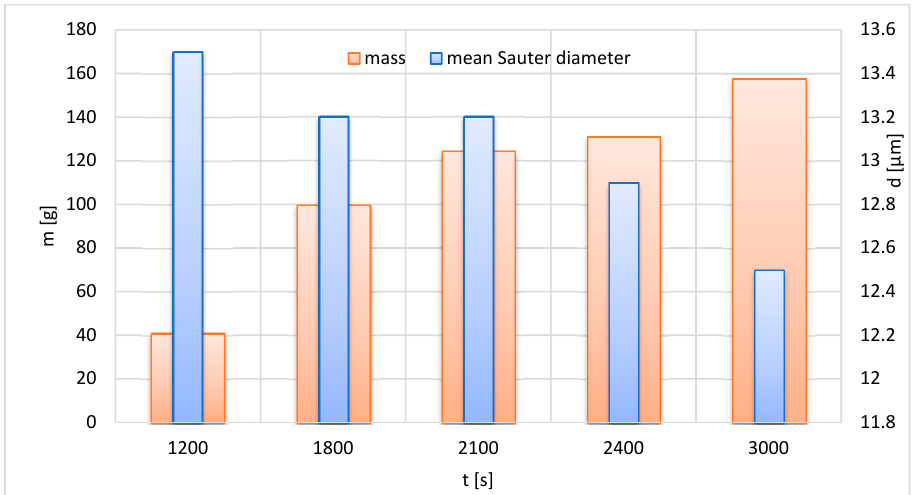
Figure 10. Effect of test conducting time on mass and mean Sauter diameter of the grinding product; p = 400 kPa, n = 150 s − 1 .